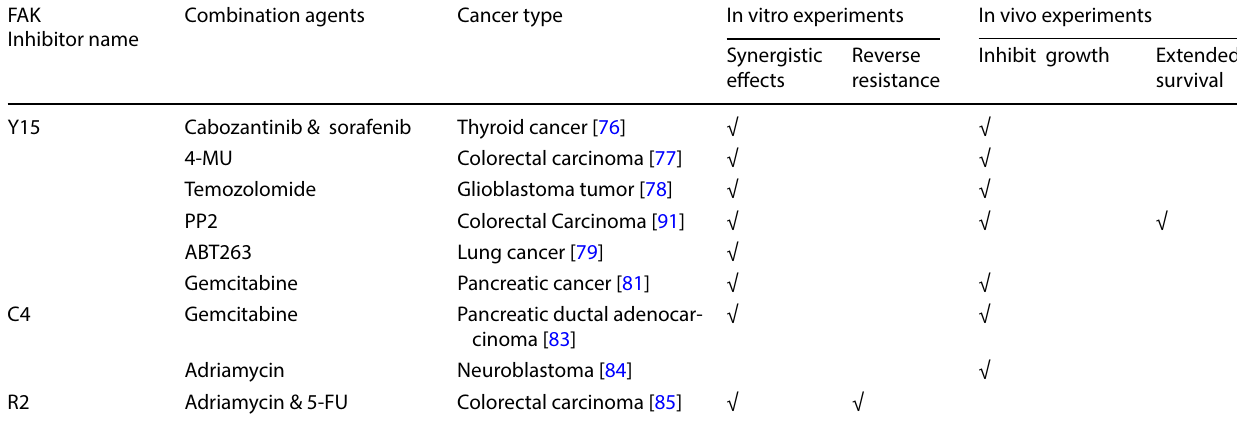
Table 3 Combination agents of specific inhibitor of FAK FAK Inhibitor